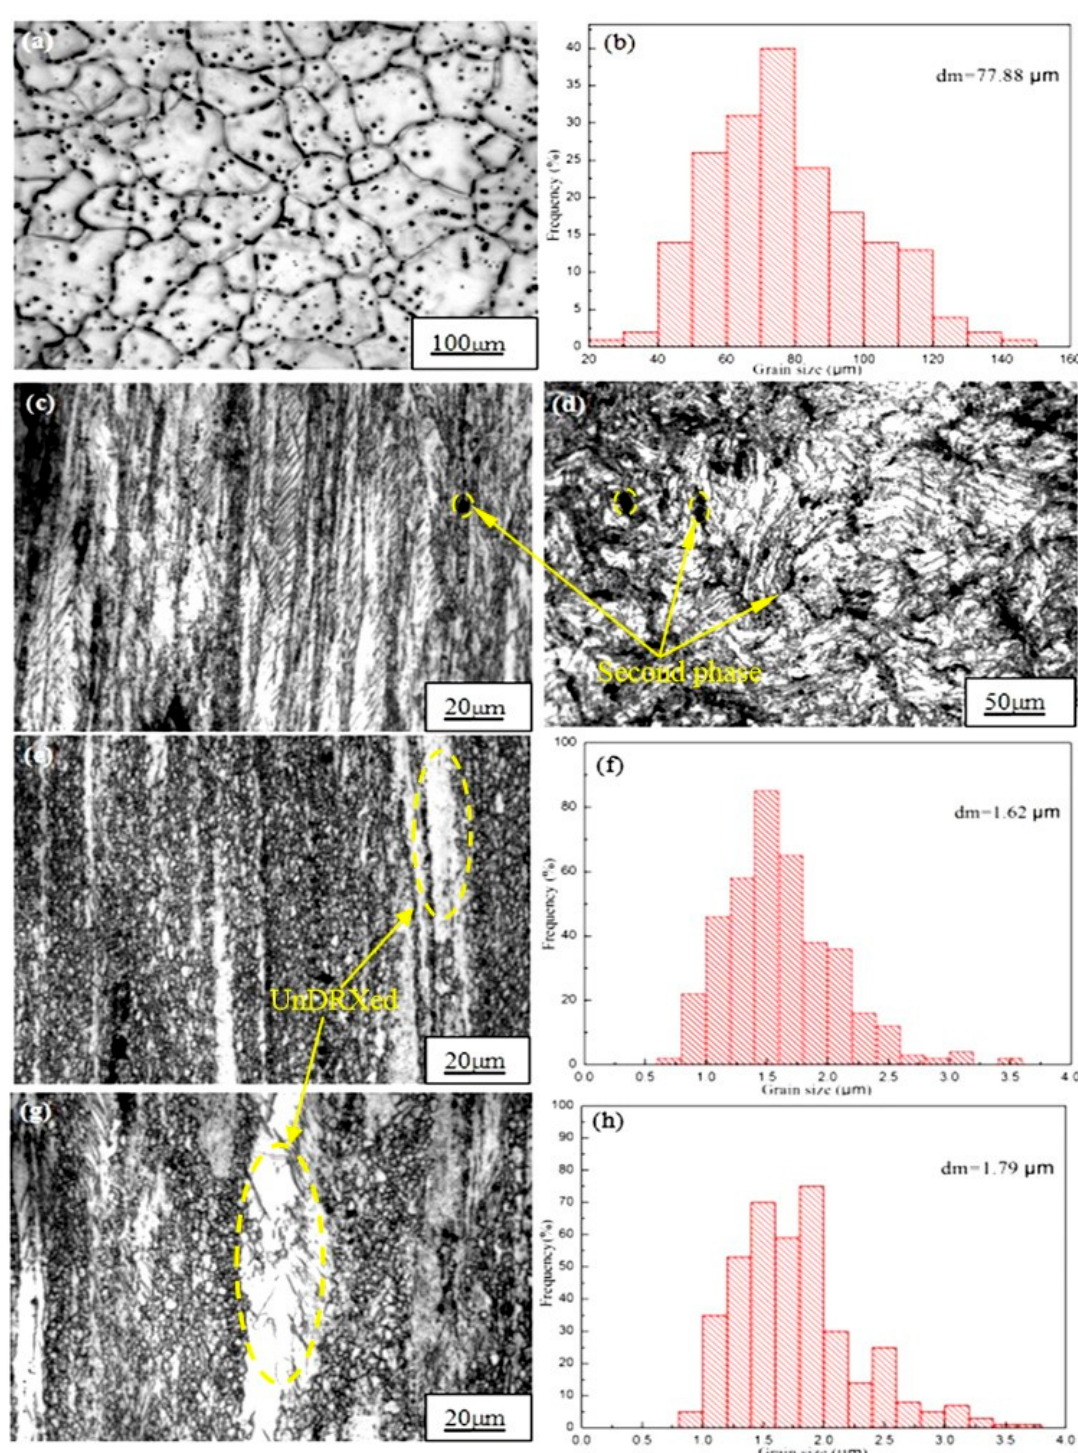
Figure 1. Optical micrographs and average grain size of alloy extruded at different temperatures: ( a , b ) As ‐ cast; ( c , d ) 250°C; ( e , f ) 300°C; ( g , h ) 350°C.